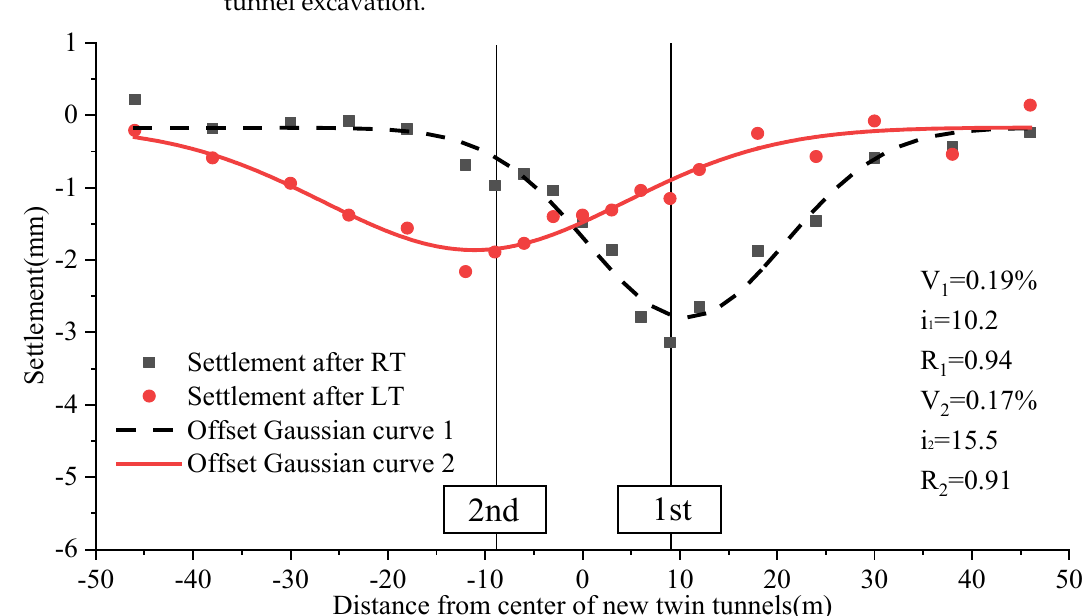
Figure 14. Measured and fitted settlement profiles.